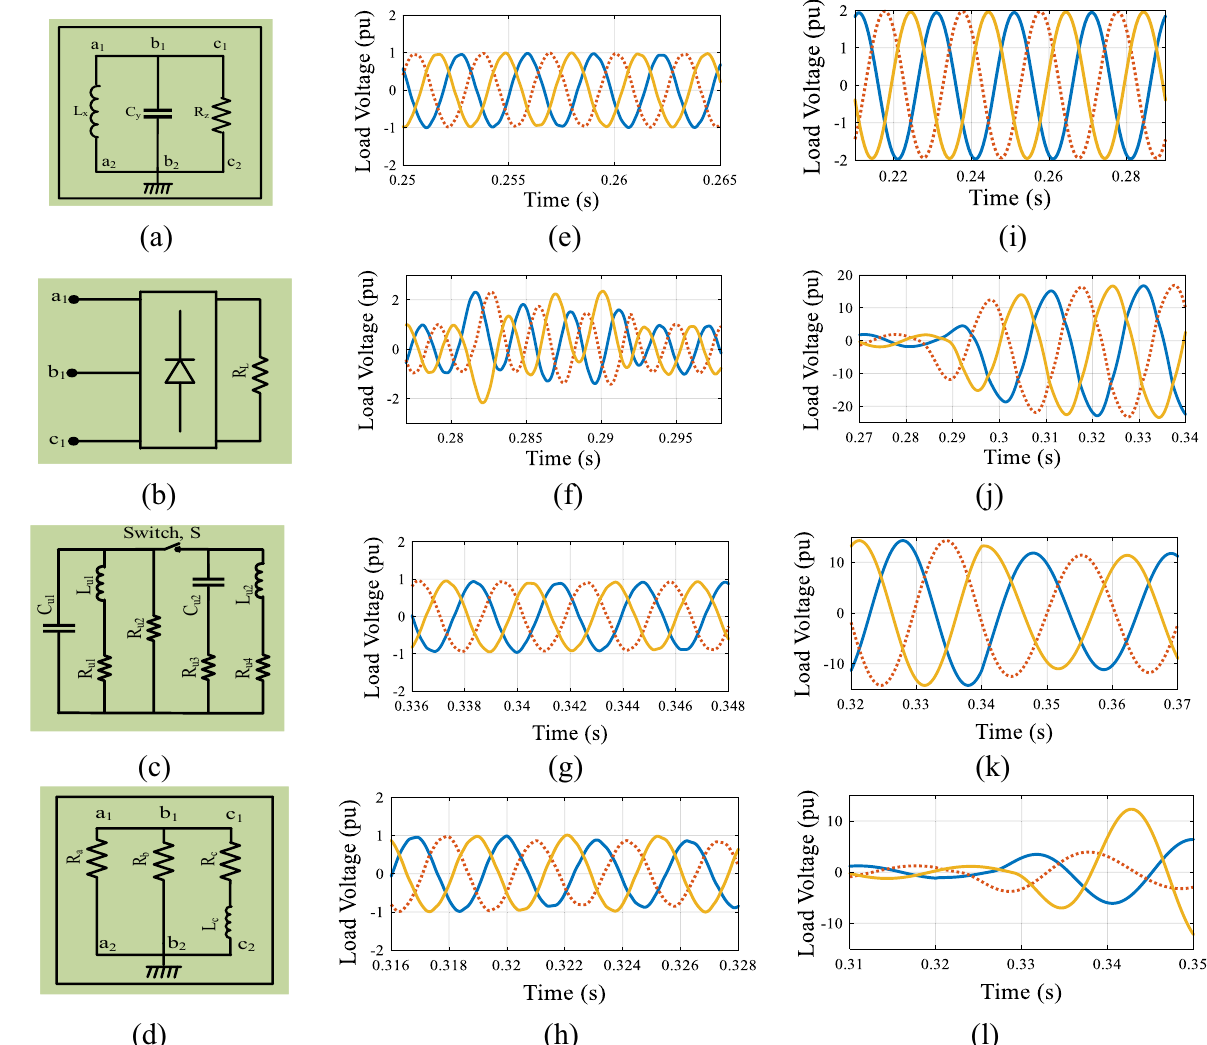
Fig. 12 Block diagram of three‑phase load a consumer, b nonlinear, c unknown, d unbalanced. Three‑phase load voltage for closed‑loop with MIMO NI‑RLLC controller for load e consumer, f nonlinear, g unknown, h unbalanced. Open‑loop load voltage response of load i consumer, j nonlinear, k unknown and l unbalanced